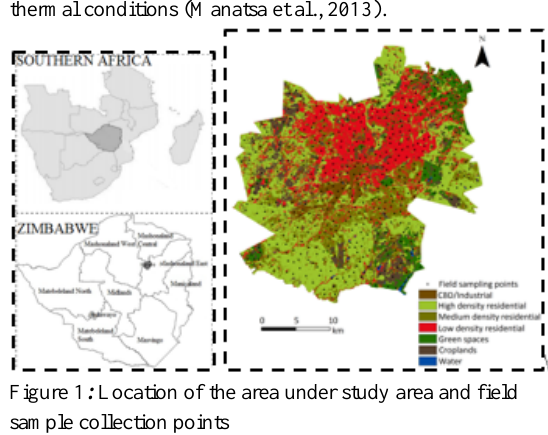
Figure 1 : Location of the area under study area and field sample collection